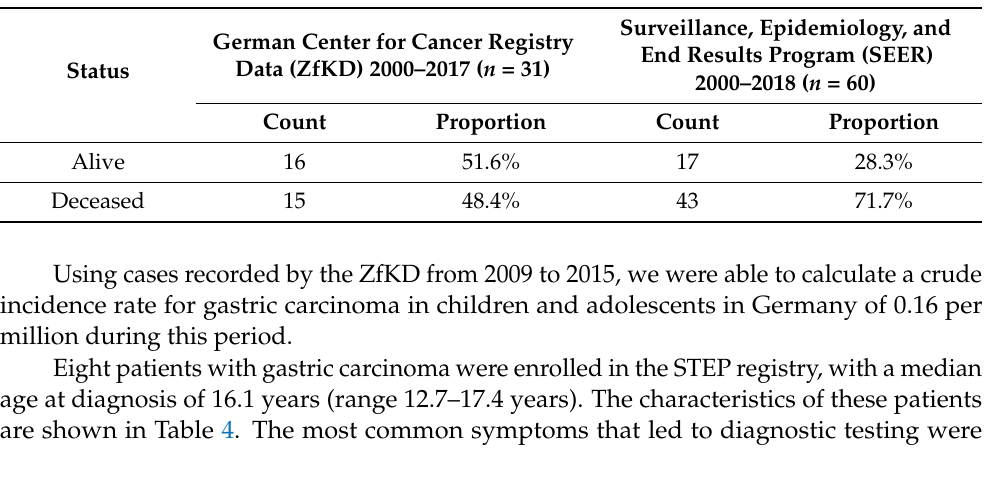
Table 3. Outcome of/last reported follow-up for gastric carcinoma in patients aged 0–19 years regis- tered at the German Center for Cancer Registry Data 2000–2017 and in the Surveillance, Epidemiology, and End Results Program